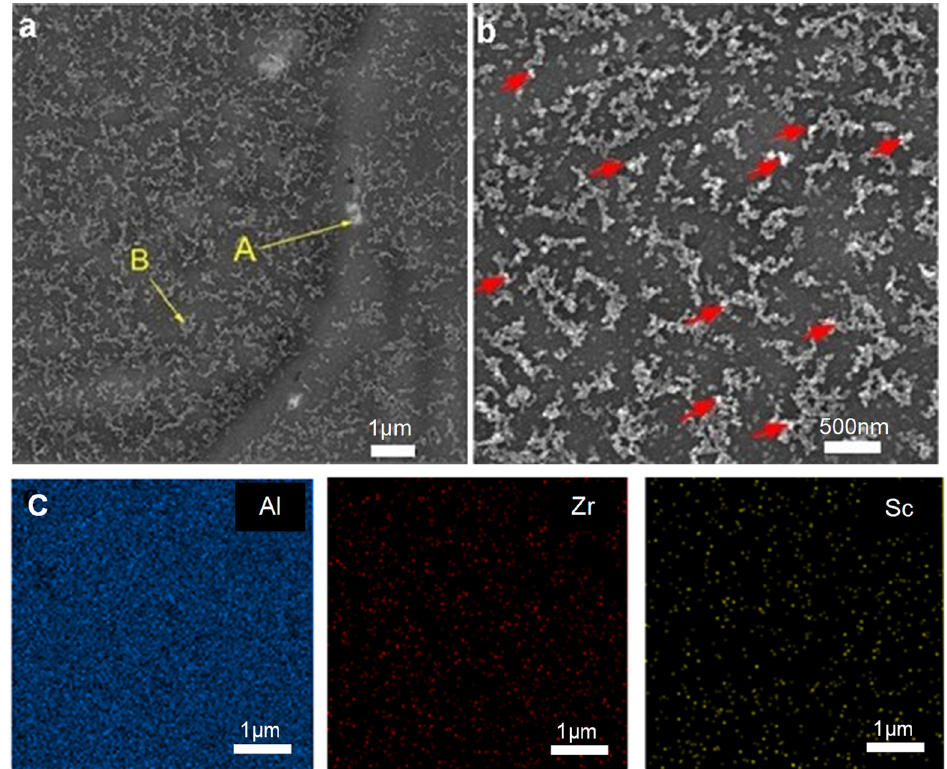
Figure 8. Distribution of MgZn 2 and Al 3 (Sc,Zr) precipitates in Al matrix in the alloy containing 0.1% Sc, under thermomechanical treatment with controlled quenching and 30% rolling: ( a , b ) Distribution of MgZn 2 and Al 3 (Sc,Zr) precipitates, and ( c ) element distribution maps. Table 4. EDS analysis of points A and B in Figure 8. Chemical Composition Phase